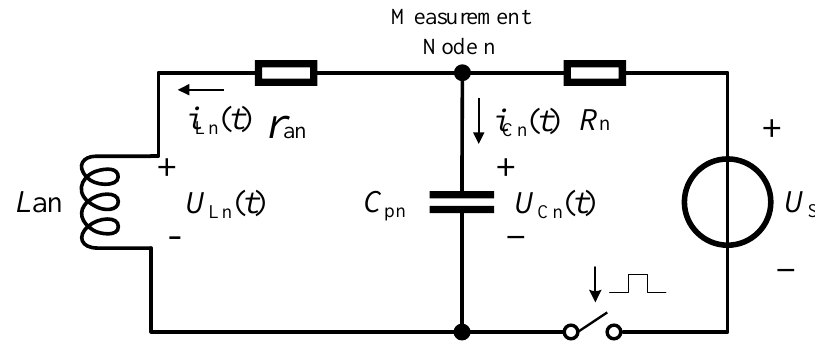
Figure 4. Equivalent circuit of the nearby sensing coil.